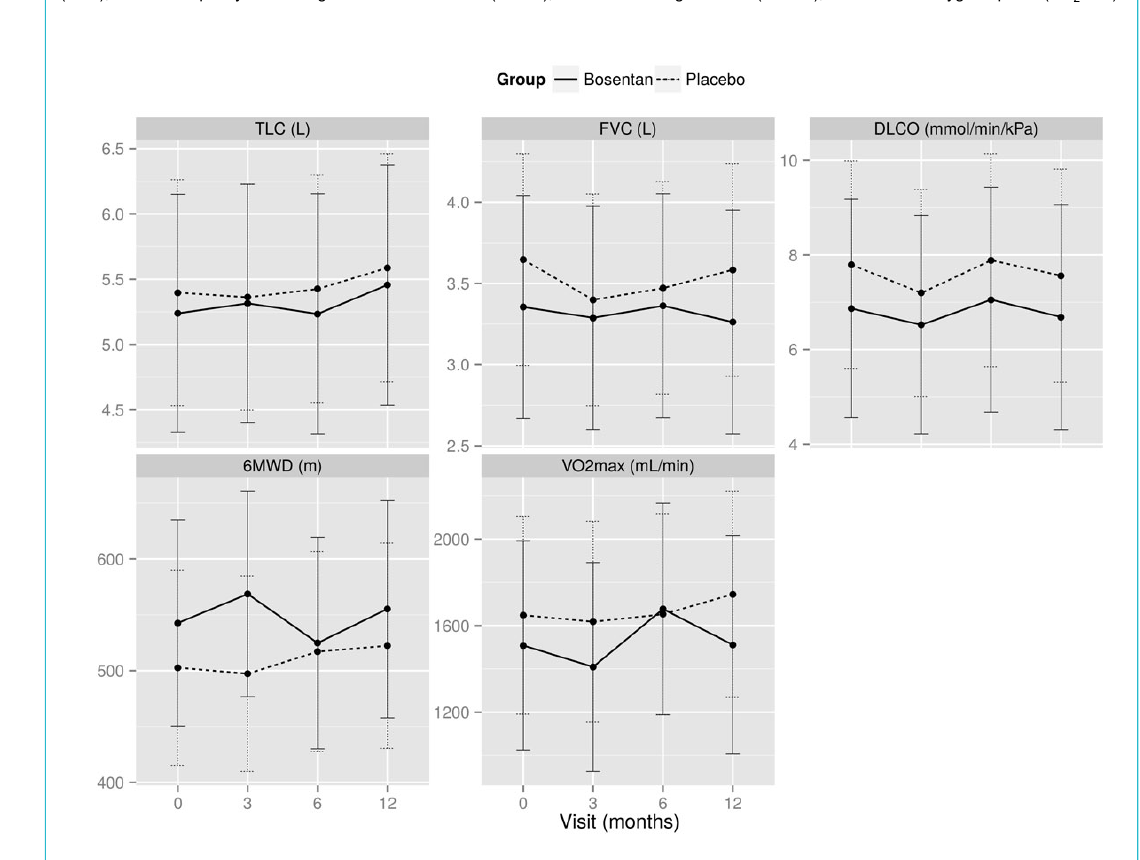
Figure 2: Evolution of mean (± SD) absolute values at baseline and months 3, 6 and 12 for total lung capacity (TLC), forced vital capacity (FVC), diffusion capacity of the lung for carbon monoxide (DLCO), 6-minute walking distance (6MWD), and maximal oxygen uptake (VO 2